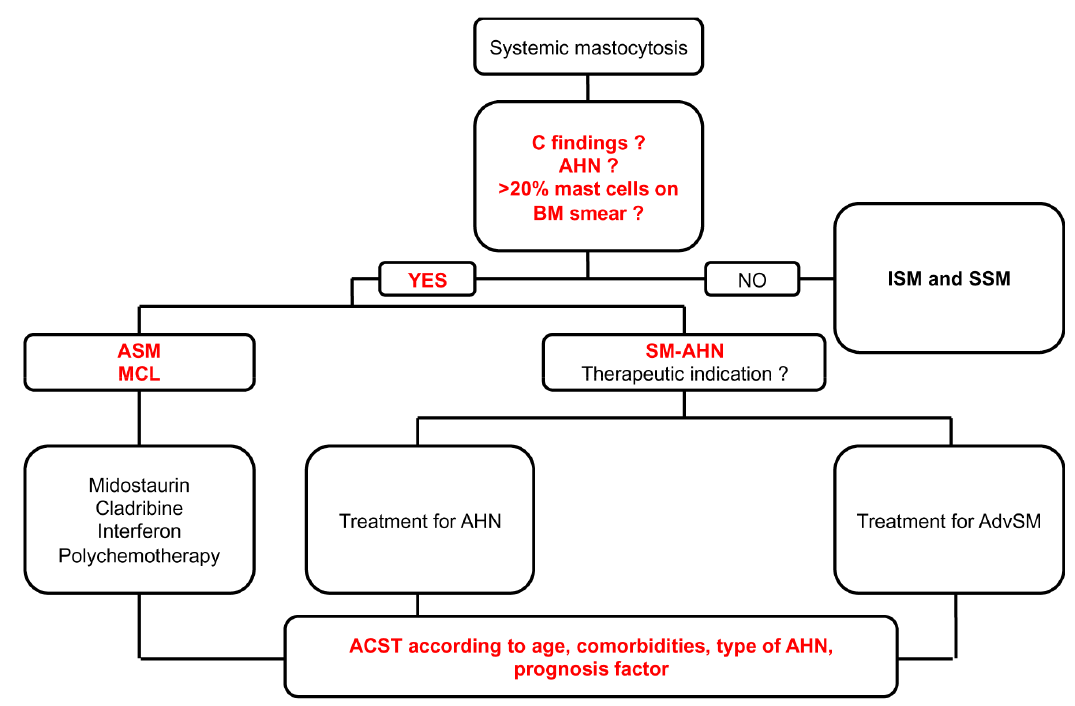
Figure 4. Treatment flow chart for advanced systemic mastocytosis. ASCT, allogeneic stem cell transplantation; AdvSM, advanced systemic mastocytosis; AHN, associated hematologic neoplasm; ASM, aggressive systemic mastocytosis; BM, bone marrow; ISM, indolent systemic mastocytosis; MCL, mast cell leukemia; SM-AHN, systemic mastocytosis with an associated hematologic neoplasm; SSM, smoldering systemic mastocytosis.